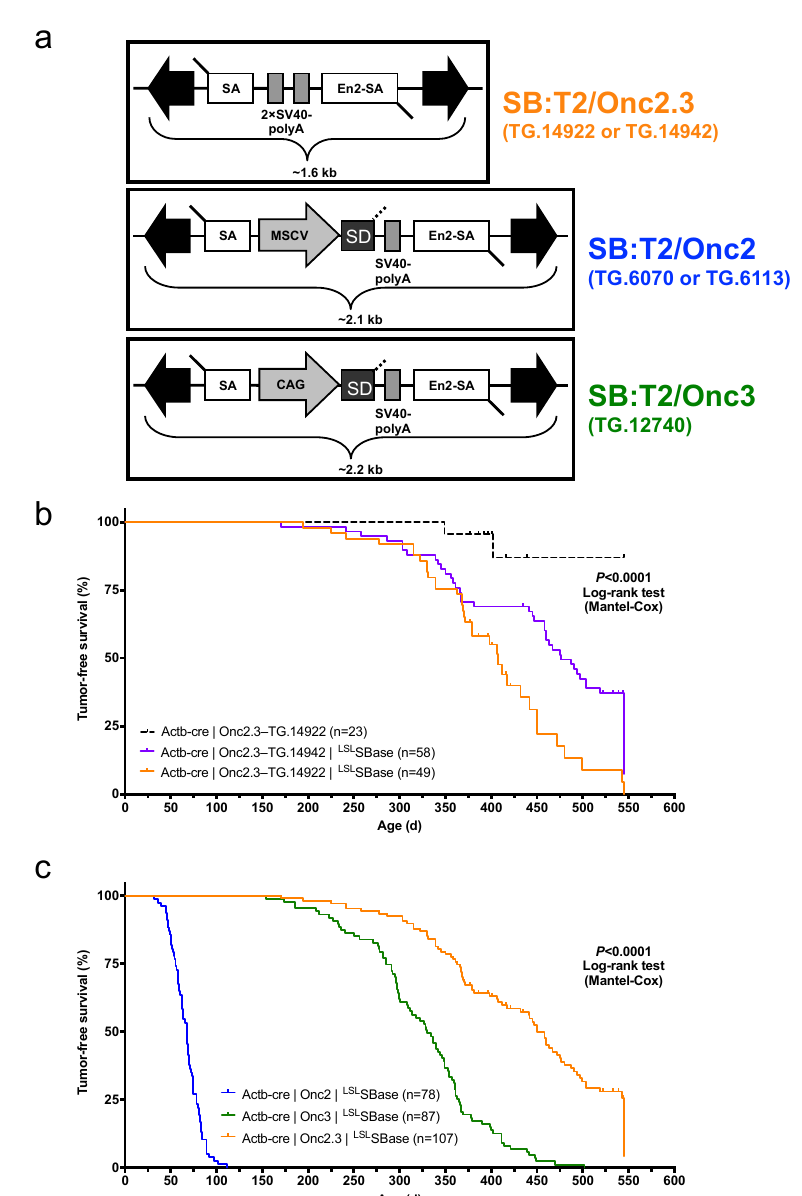
Figure 1. Whole-body, gene-trap exclusive SB transposon mutagenesis results in tumor formation in SB-Onc2.3 mice. ( a ) Comparing Sleeping Beauty transposons used in this study (T2/SB-GT and T2/Onc3) and in a similar companion study (T2/Onc2). Abbreviated allele designations for founder lines used in this work are shown to the right of each vector. ( b ) Kaplan–Meier survival plots comparing experimental and control SB-Onc2.3 cohorts (Mantel–Cox log-rank test, P < 0.0001, Figure S1). Mice in all SB-Onc2.3 cohorts with active SB mobilization developed solid tumors at multiple organ sites, however SB-Onc2.3-TG.14922 mice (orange line) had significantly decreased survival compared to the SB-Onc2.3-TG.14942 mice (purple line; Mantel–Cox log-rank test, P = 0.0015). ( c ) Kaplan–Meier survival plots comparing the relative tumor latency between various SB cohorts with whole-body mobilization by a conditionally activated from the Rosa26 - LSL SBase allele to the Rosa26 -1lox-SBase allele by whole body Beta-actin-driven Cre expression, including SB-Onc2 mice (combined data from TG.6070 and TG.6113 alleles containing an MSCV-promoter [9]), SB-Onc3 (data from TG.12740 allele containing a CAG-promoter [17]), and SB-Onc2.3 (combined data from TG.14922 and TG.14922 alleles containing no promoter) (Mantel–Cox log-rank test, P < 0.0001, Table 1).